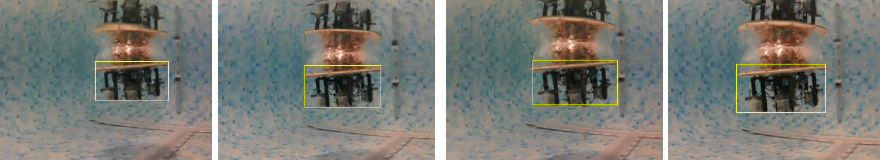
Figure 22. Images of second-level follower perspective and follower perspective of the three-robot “V-type escort” following formation experiment.